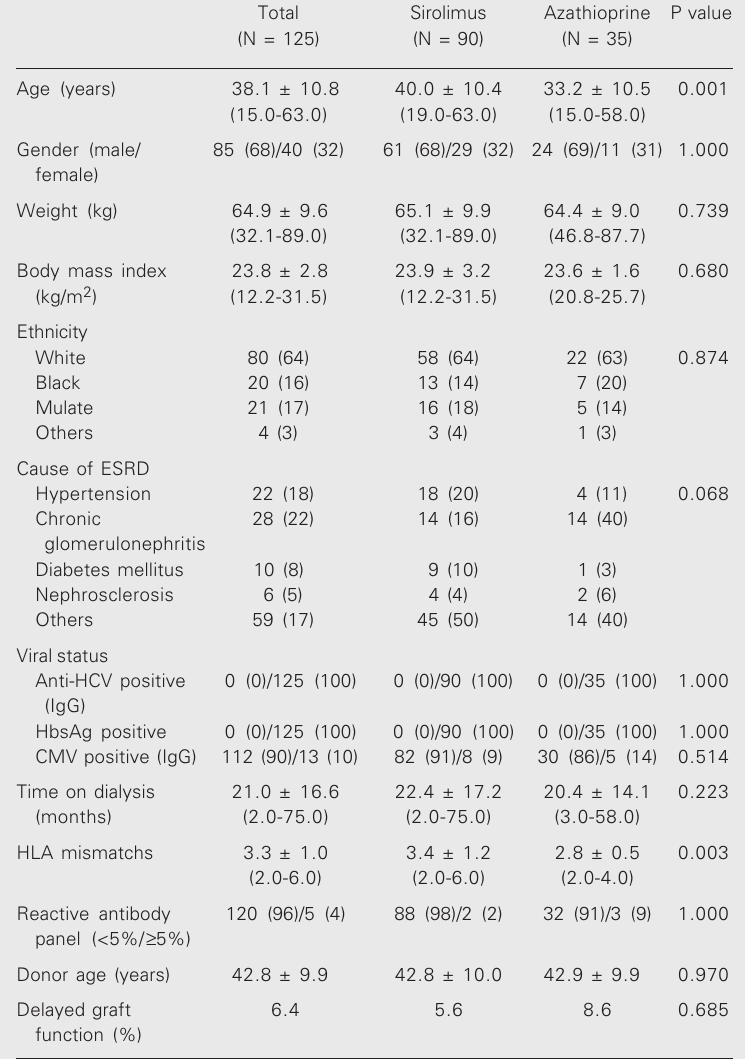
Table 1. Demographic characteristics of the transplant